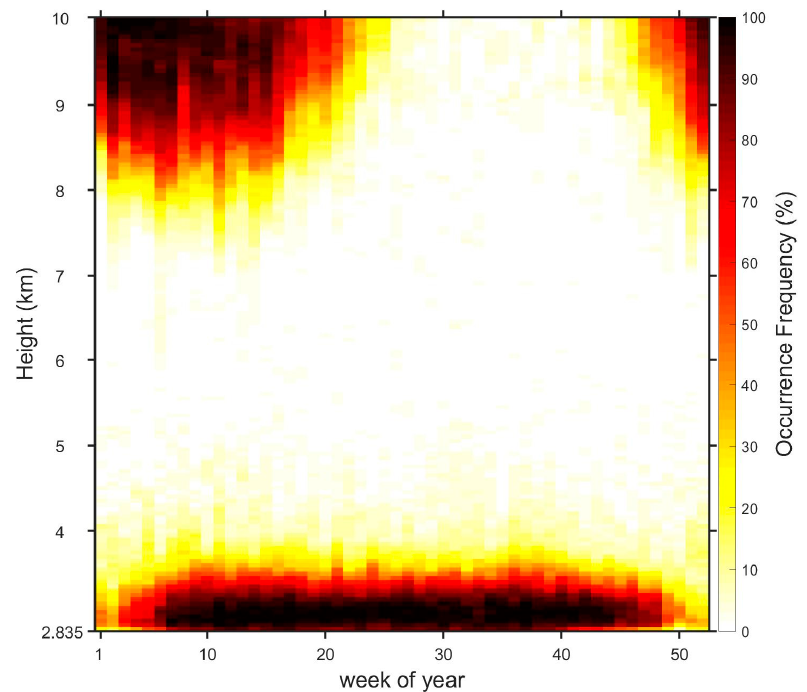
Figure 3. Occurrence frequency of temperature inversion layers in weekly slots at each height level up to 10 km during 2005 – 2018.